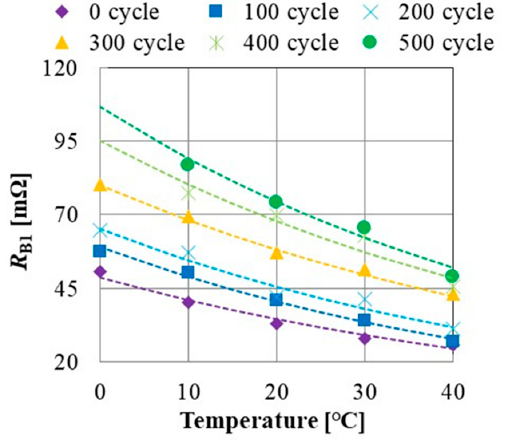
Figure 11. Effect of charging cycle on integrated voltage.